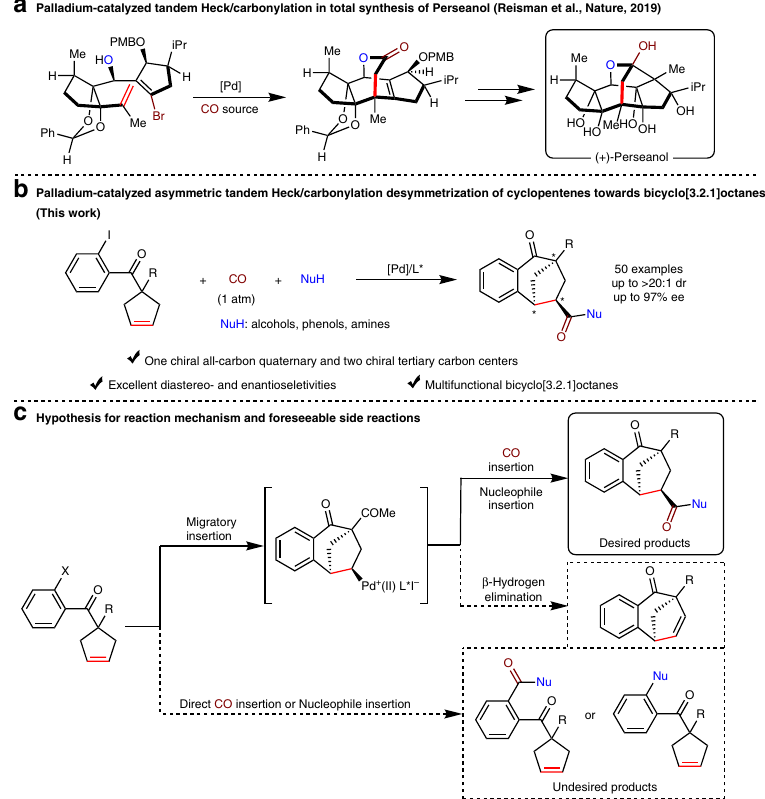
Fig. 1 Palladium-catalyzed tandem Heck/carbonylation reactions of alkenes. a Pd-catalyzed tandem Heck/carbonylation as key step to the total synthesis of ( + )-Perseanol. b Palladium-catalyzed asymmetric tandem Heck/carbonylation of internal alkenes towards bicyclo[3.2.1]octanes (this work). c Hypothesis of mechanism for the tandem Heck/carbonylation reaction and foreseeable side